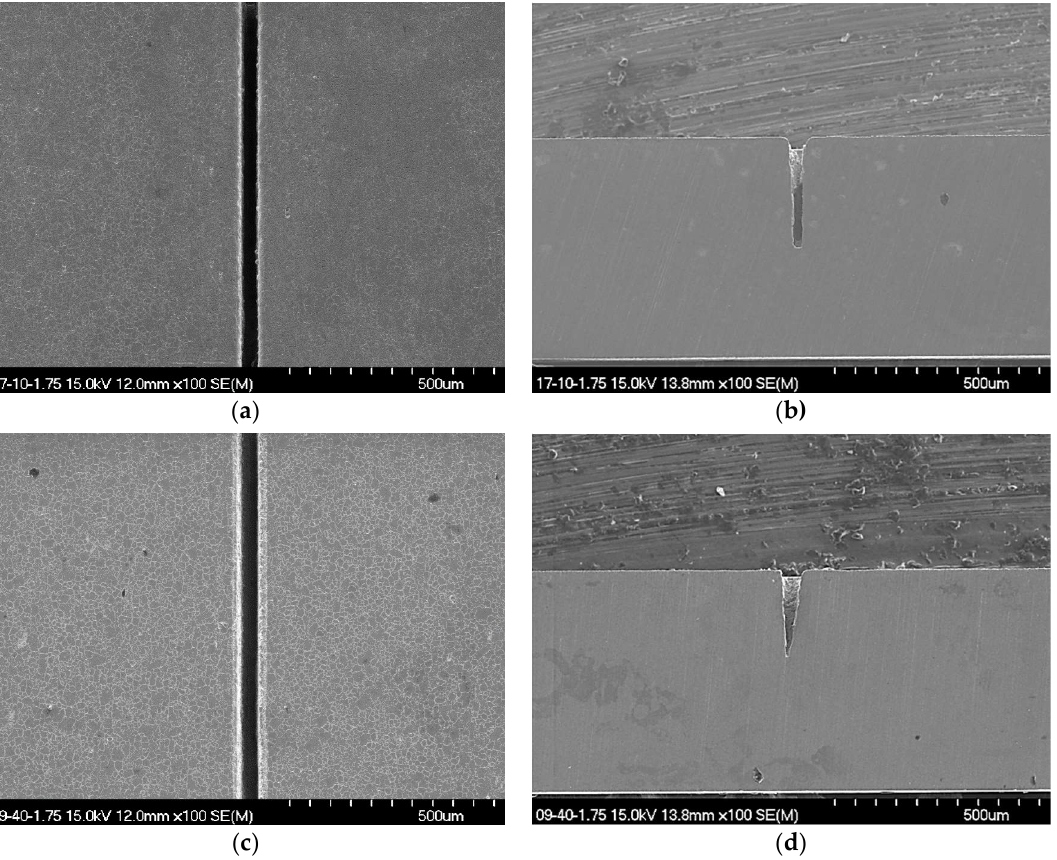
Figure 5. Scanning electron micrographs for the surface morphologies and cross-sectional profiles of stainless-steel 304 microgrooves processed at two different H 3 PO 4 concentrations of 10% ( a , b ) and 40% ( c , d ) utilizing the lens-based LIE. Other process variables were a laser power of 1.75 W and scan speed of 10 μm/s.